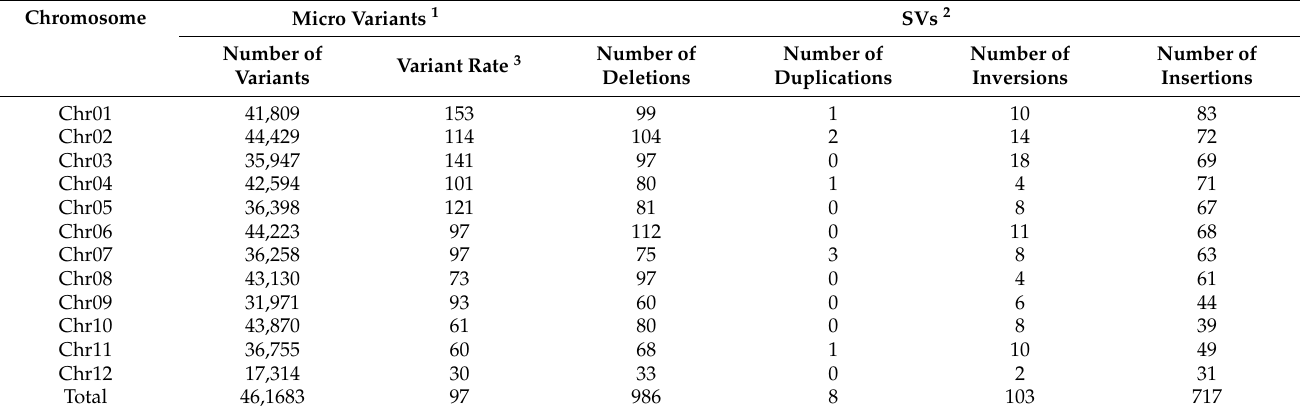
Table 4. Micro variant and structural variant (SV) rate details per